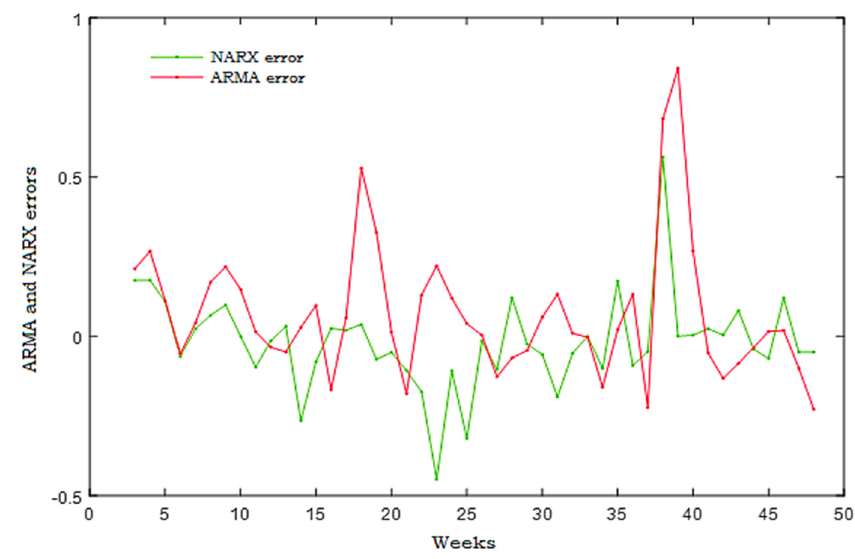
Figure 34. ARMA and NARX errors for solar radiation prediction.